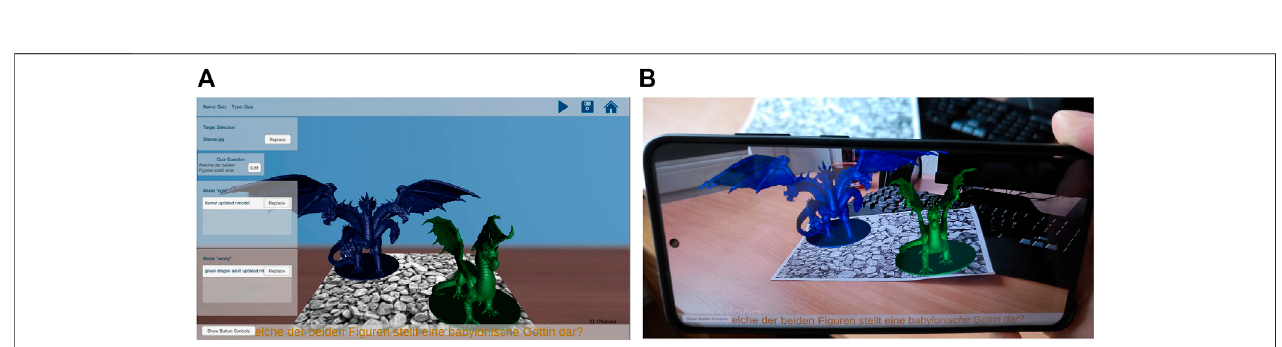
FIGURE5| PicturesofaquizARnugget thatwasimplemented byaperson withoutprogrammingknowledge usingtheARnuggetauthoringtool. (A) :Screenshot from the desktop device. (B) : Image using the AR device.